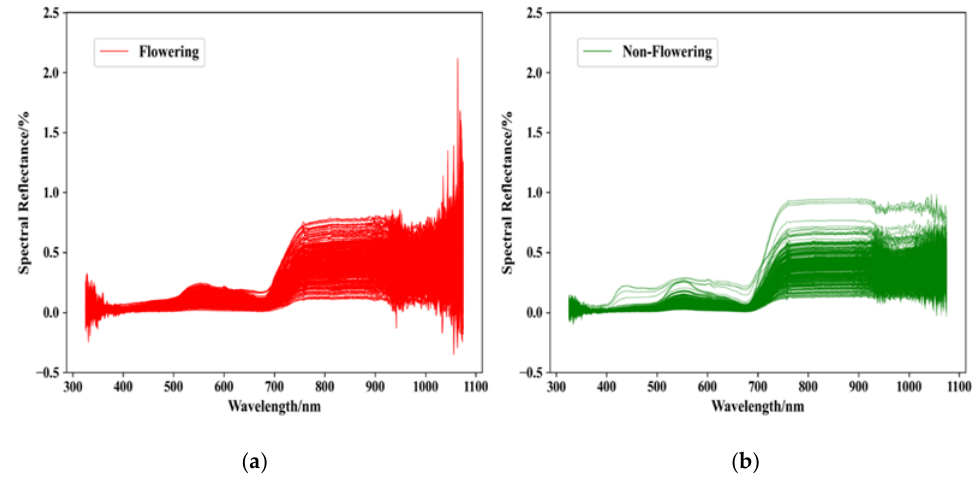
Figure 4. Relationship between reflectance and wavelength of flowering and non-flowering spike- lets of Rice in Hainan province ( a ) non-flowering spikelets; ( b ) flowering spikelets.